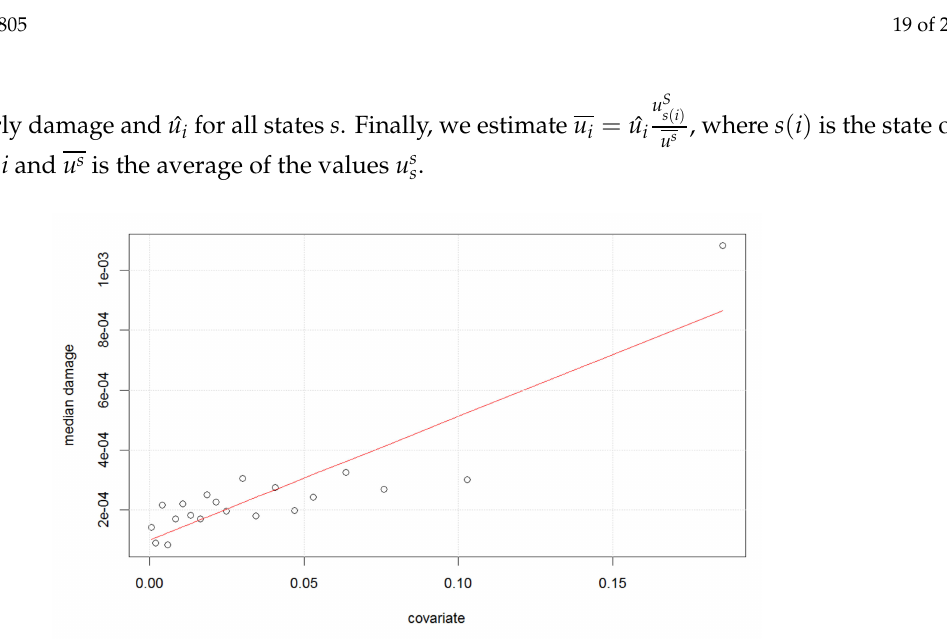
Figure A3. Median of the covariate (fraction of built-up area in the HQ100 zone against the median of the normalized damage.